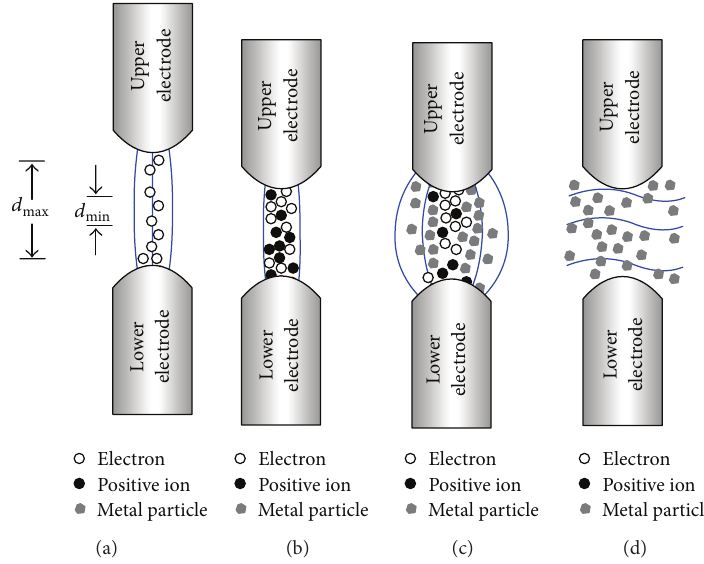
Figure 1: Process of preparing nanometal colloid by ESDM.